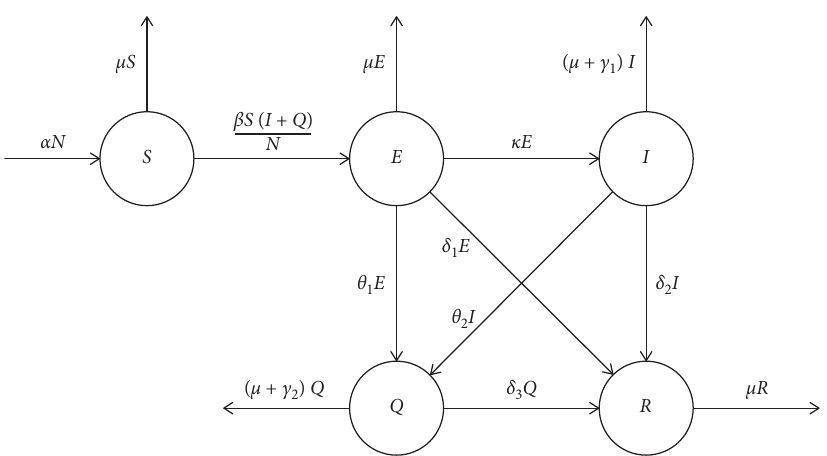
Figure 1: Compartmental model for COVID-19 transmission